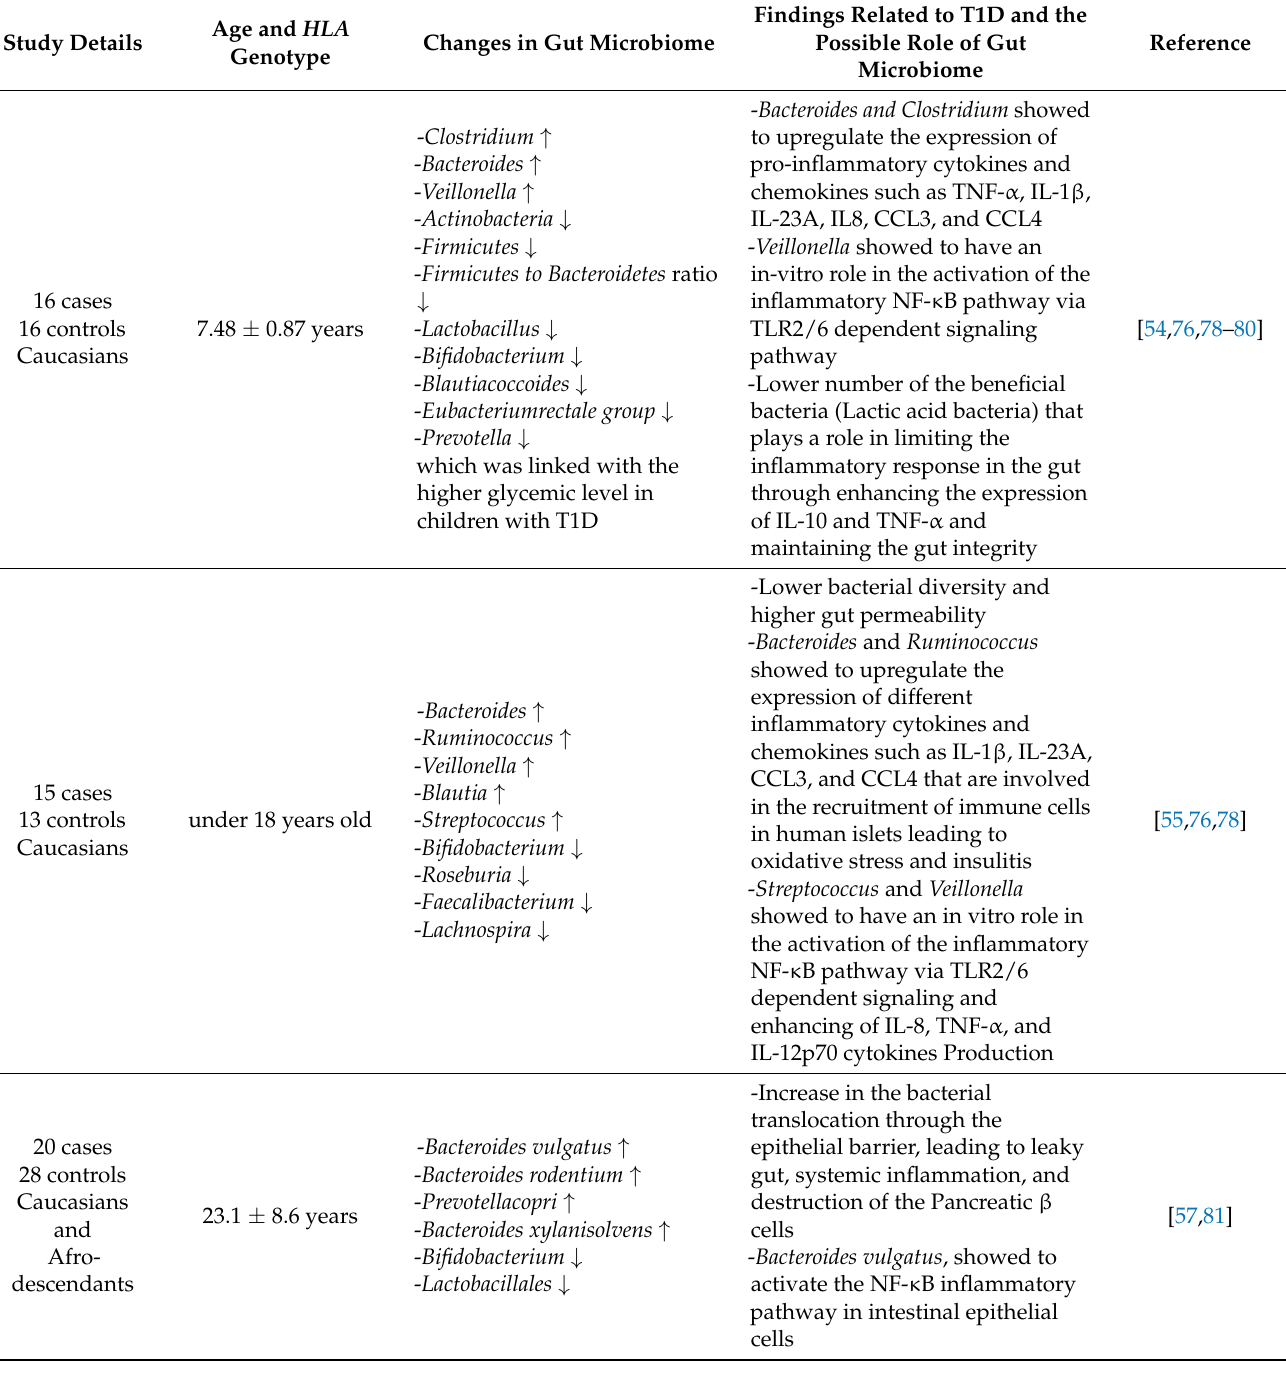
Table 1. List of studies describing changes in the gut microbiome composition in individuals with